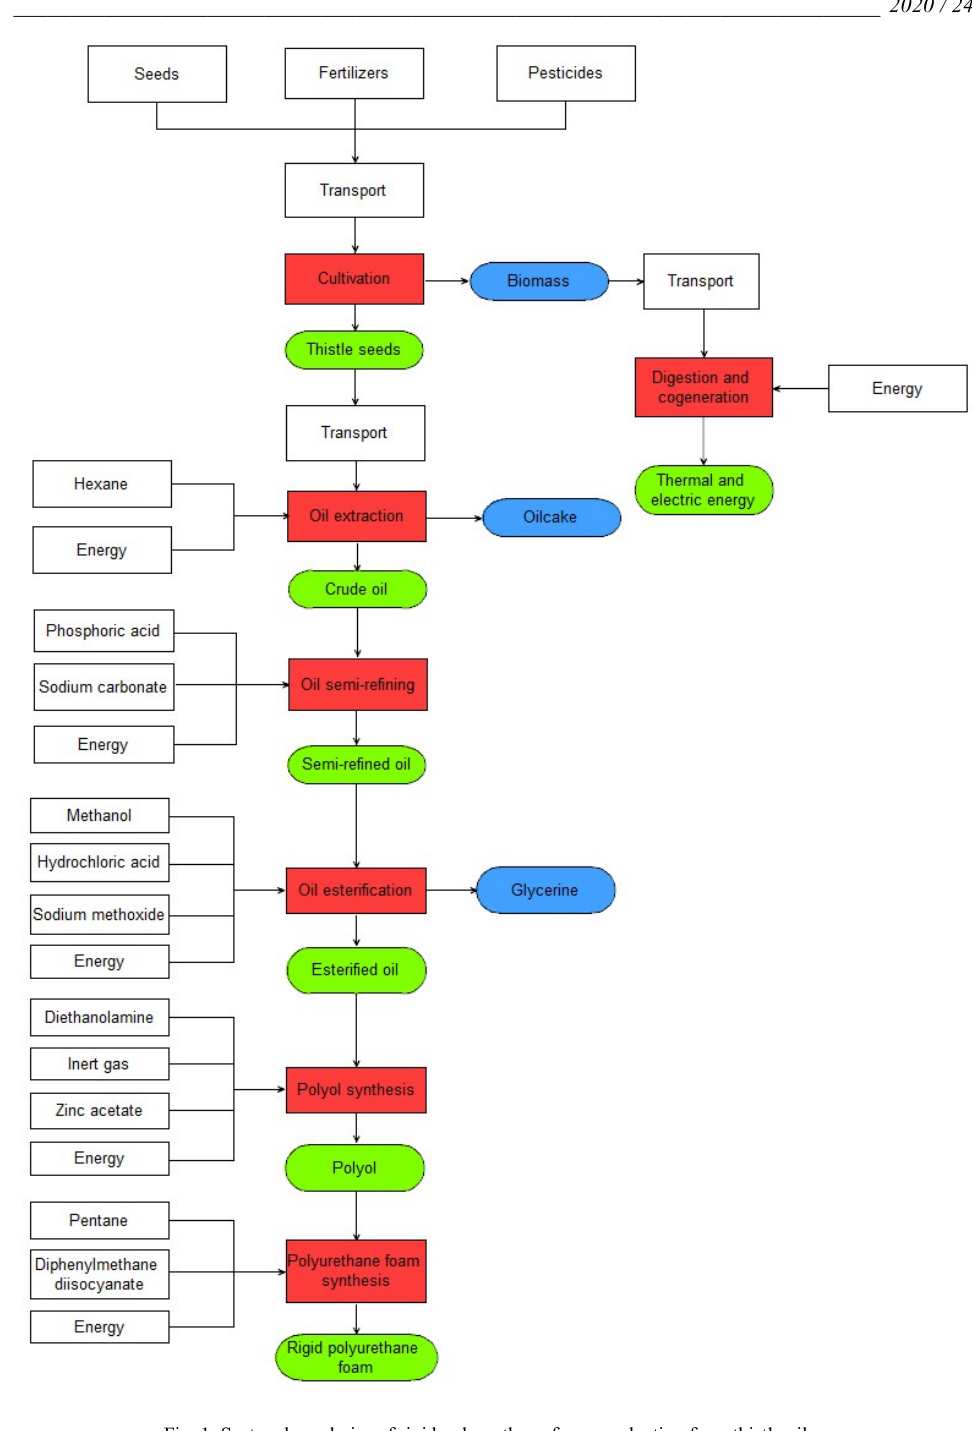
Fig. 1. System boundaries of rigid polyurethane foam production from thistle